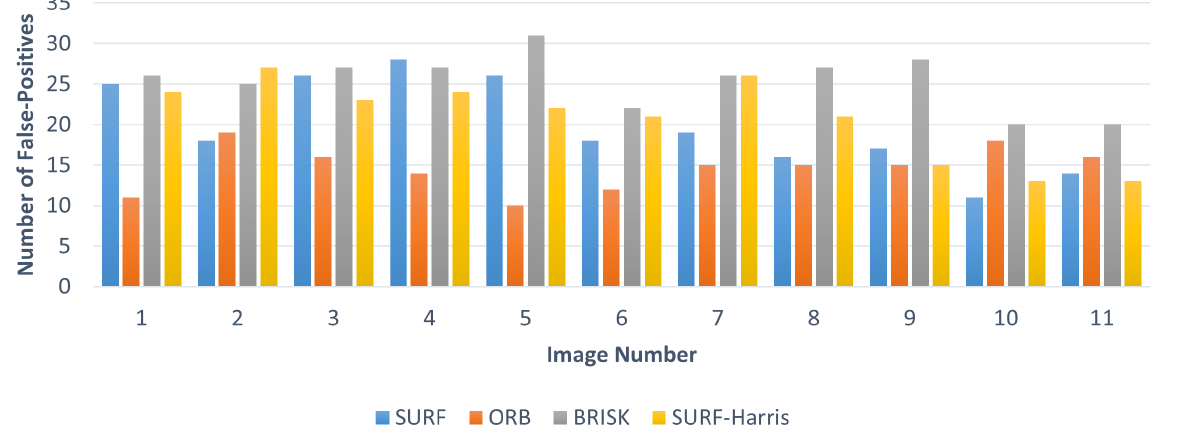
Figure 25. Number of false-positives detected amongst the 50 best interest points detected in each image of dataset 2 employing the selection